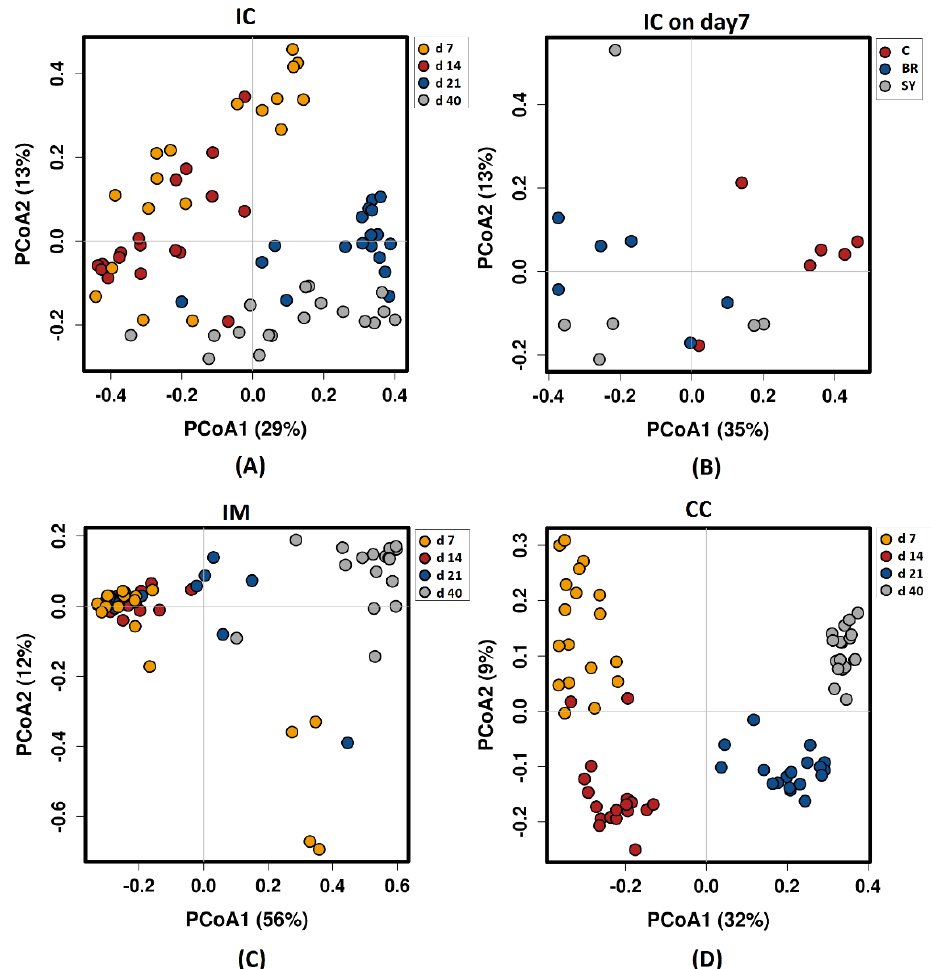
Figure 2. Principal coordinate analysis (PCoA) based on Bray—Curtis dissimilarity matrix on sampling sites: ( A ) Ileal chymus age effect; ( B ) Ileal chymus dietary treatment effect at d 7; ( C ) Ileal mucosa age effect; ( D ) Caecal chymus age effect. Dietary treatments were C—Control, Br—Broilact ® , Sy—Synbiotic feed additive. The percentage of variation explained by each PCoA is indicated on the axes with Bray—Curtis dissimilarity. To verify the significance of bacterial community analysis of similarities (ANOSIM) calculations were performed with 999 permutations. The differences were considered significant at a level of p ≤